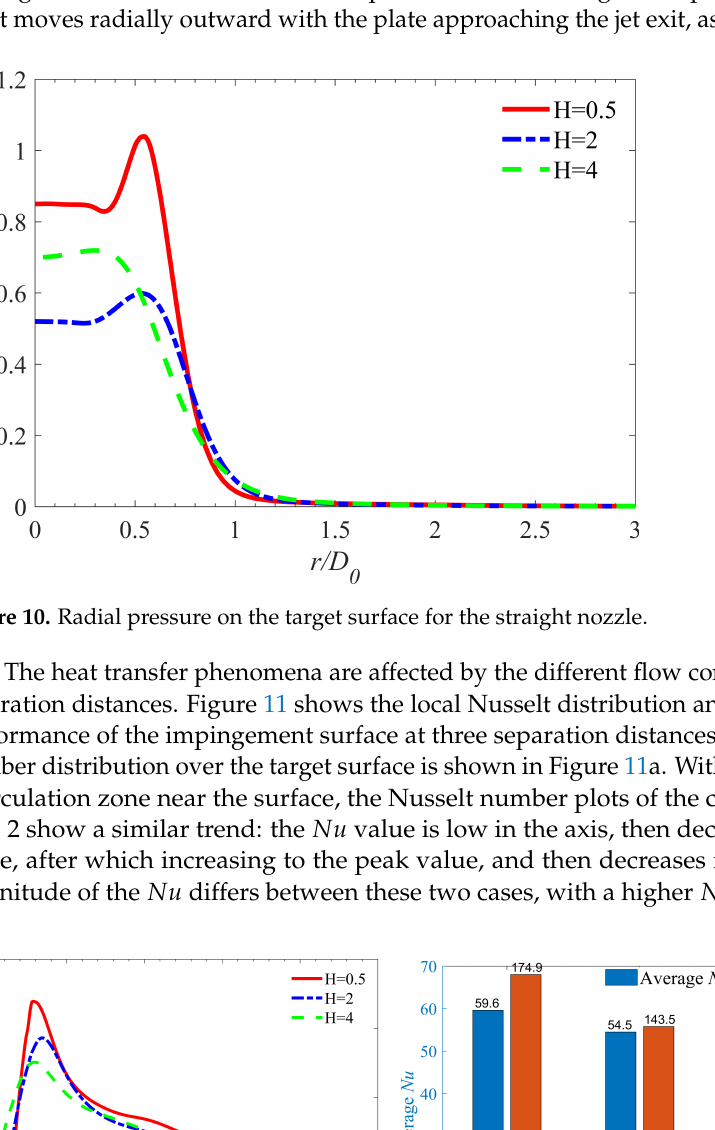
Figure 11. Heat transfer performance for the straight nozzle: ( a ) Radial Nusselt plots. ( b ) Average and peak Nusselt number on the impingement